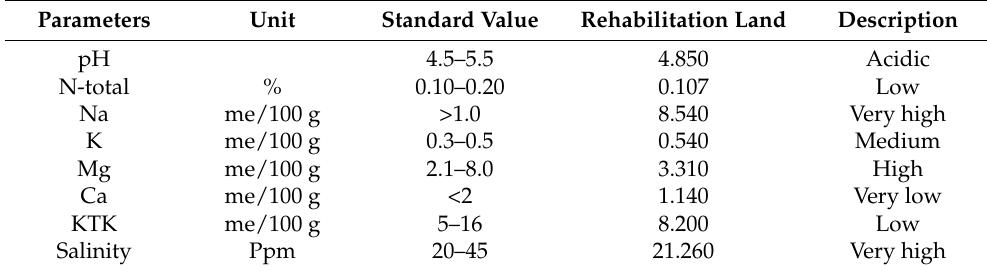
Table 13. Analysis of soil chemical properties for planting rehabilitation using propagules.